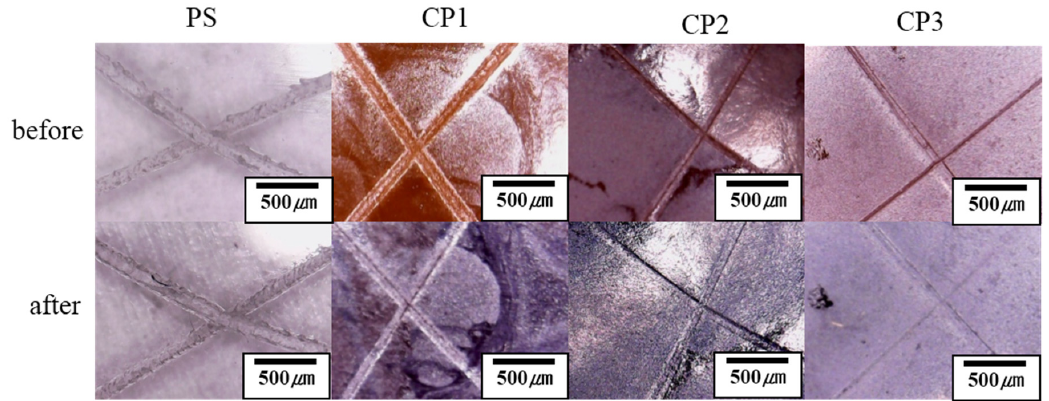
◦ C before and after thermal treatment. Polymers 2019 , 11 , x FOR PEER REVIEW